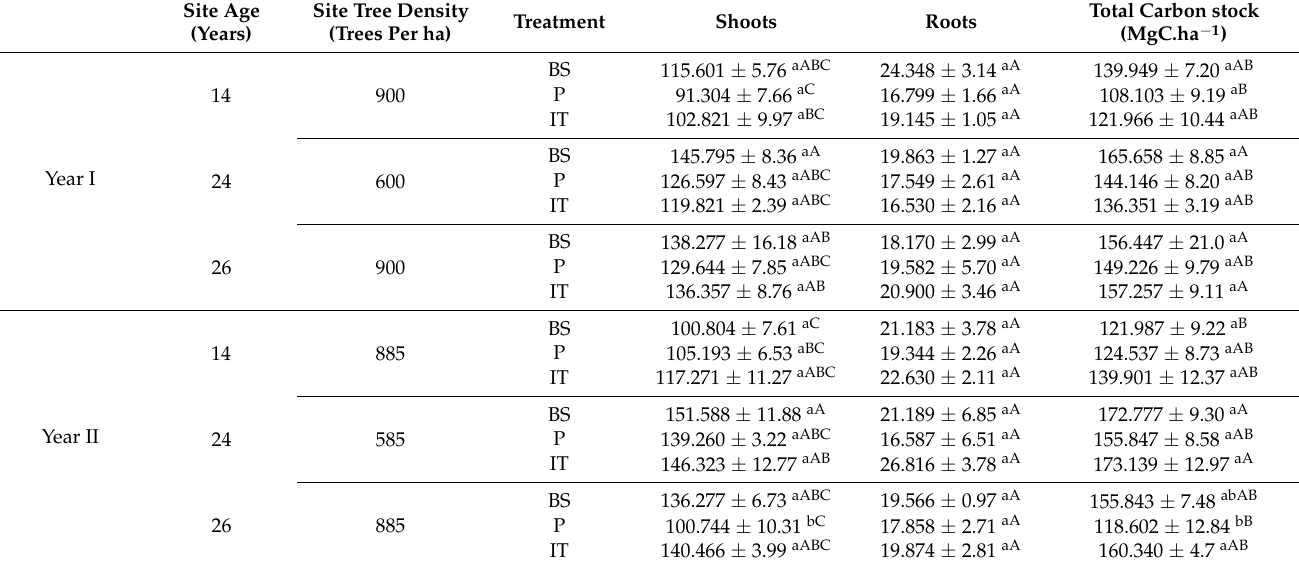
Table 4. Aboveground, belowground, and total carbon stock in biomass of slash pine plantations of three different ages under different tapping treatments.